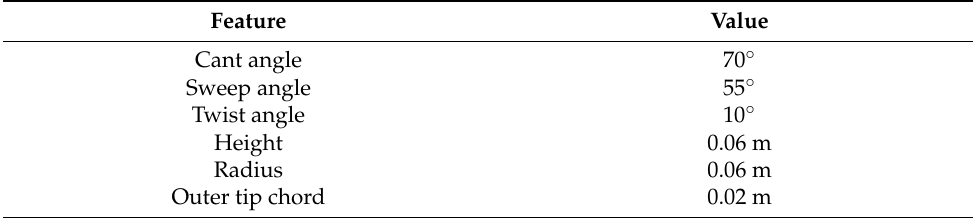
Table 2. Features of the designed winglet.